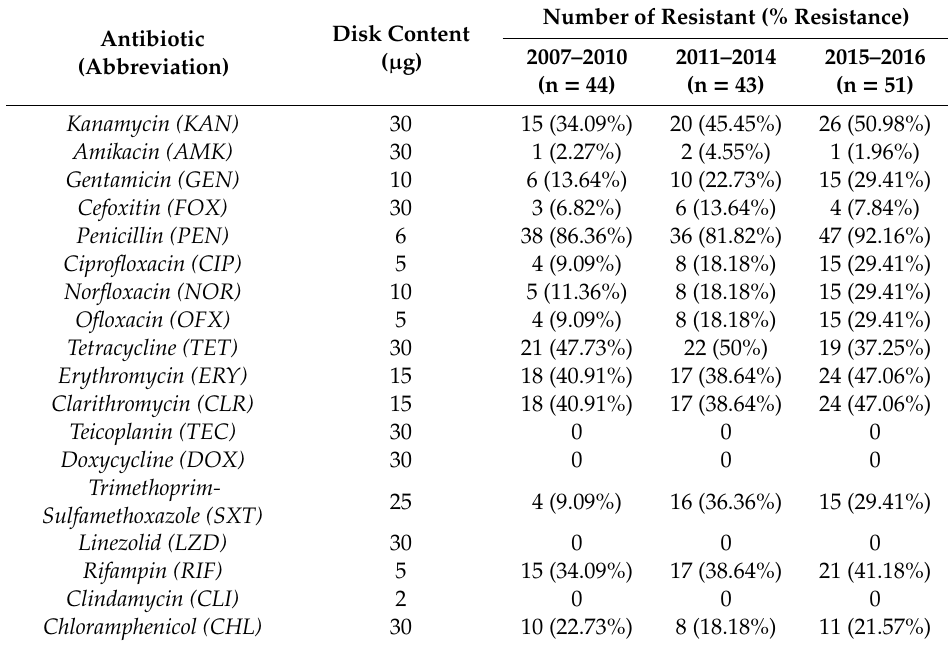
Table 3. Rates of antimicrobial resistance of 3 S. schleiferi , 19 S. aureus and 117 S. pseudintermedius isolates recovered at the Complutense Veterinary Teaching Hospital (Spain) during di ff erent